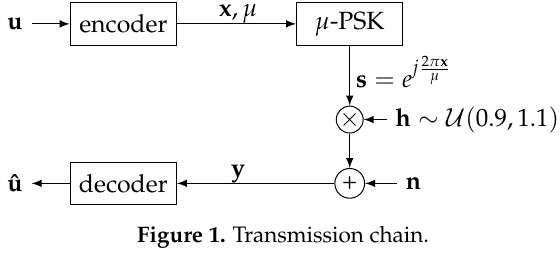
Figure 1. Transmission